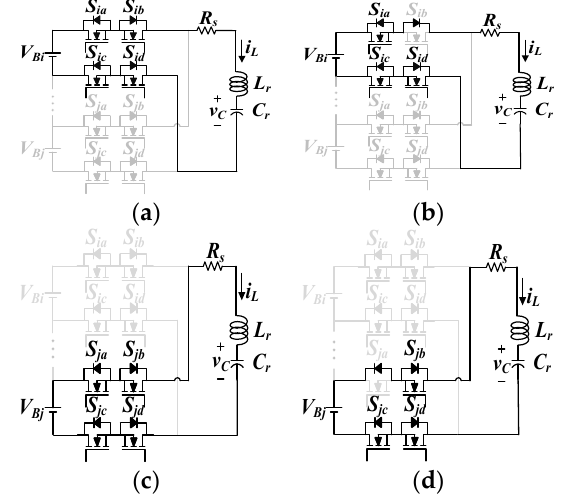
Figure 4. The circuit’s operation in normal balance mode: ( a ) Interval I; ( b ) Interval II; ( c ) Interval III;